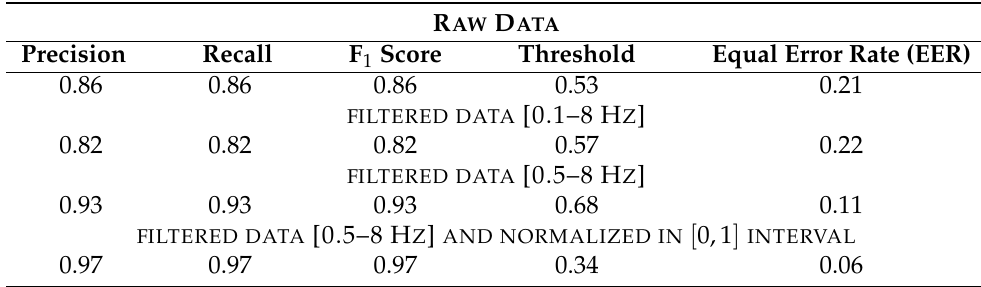
Table 3. Performance metrics for all the input PPG signal modalities used in the case of leaving 40% of data out of training. The thresholds refer to the optimal classification thresholds where EER is minimal for each modality (preprocessing)